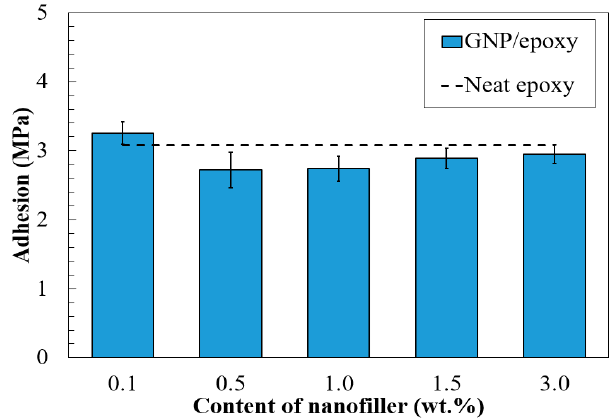
Figure 11. Adhesion strength of the composite coatings to the substrate.